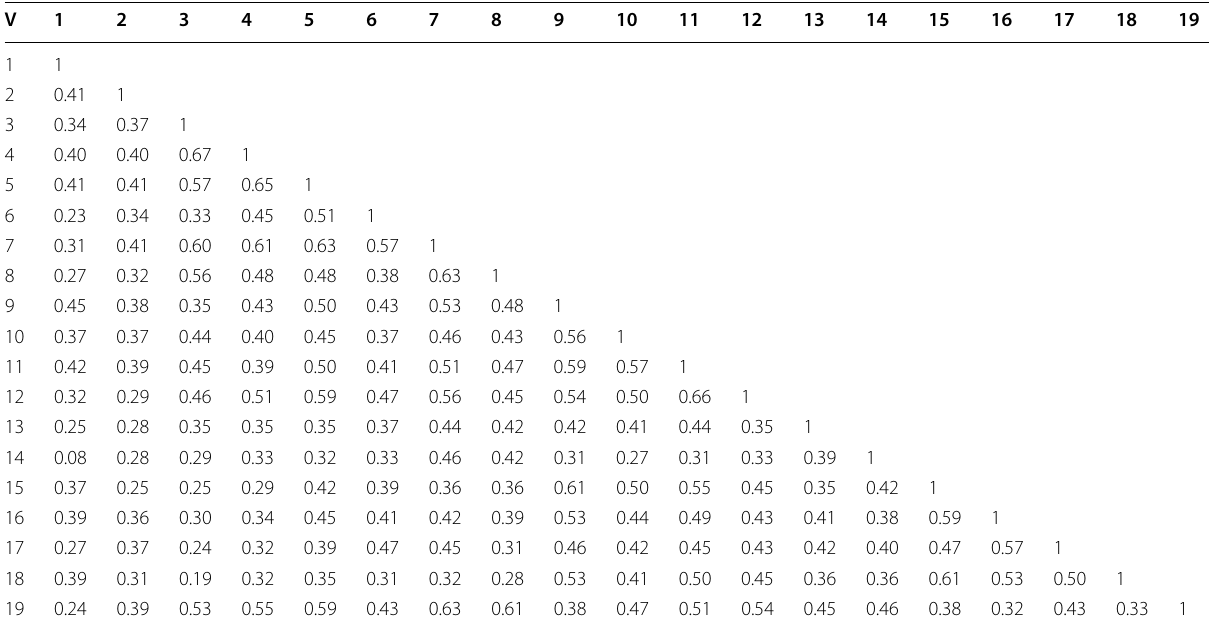
Table 4 Matrix of polychoric correlations of all 19 items of the EEAPREJ